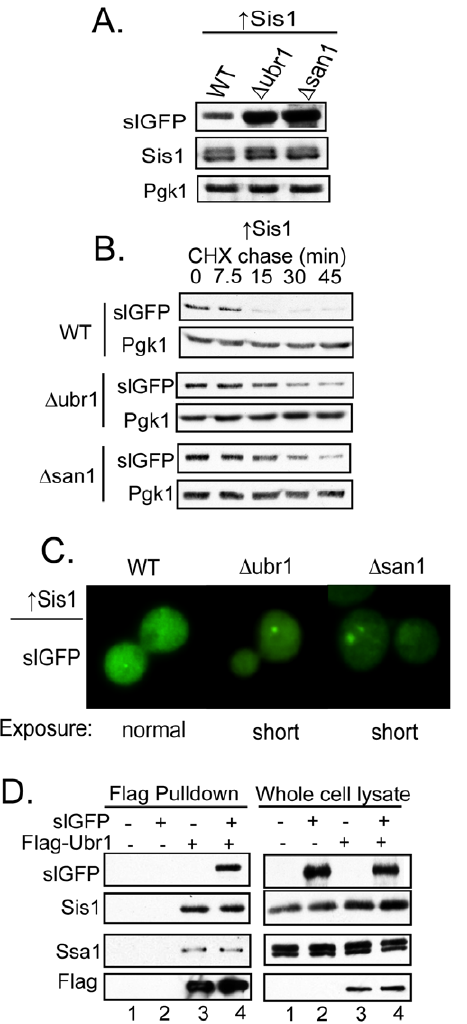
Figure 6. Acceleration Of SlGFP Degradation By Sis1 Requires Ubr1 Or San1. A) SlGFP levels in WT, D ubr1 or D san1 strains where Sis1 is overexpressed. B) Cycloheximide-chase analysis of slGFP turnover. C) Fluorescence microscopy of slGFP. D) Endogenous Sis1 and slGFP form a complex with Flag-Ubr1. Flag-Ubr1 was isolated from cell extracts using Flag-affinity resin and associated proteins eluted with Flag peptide.